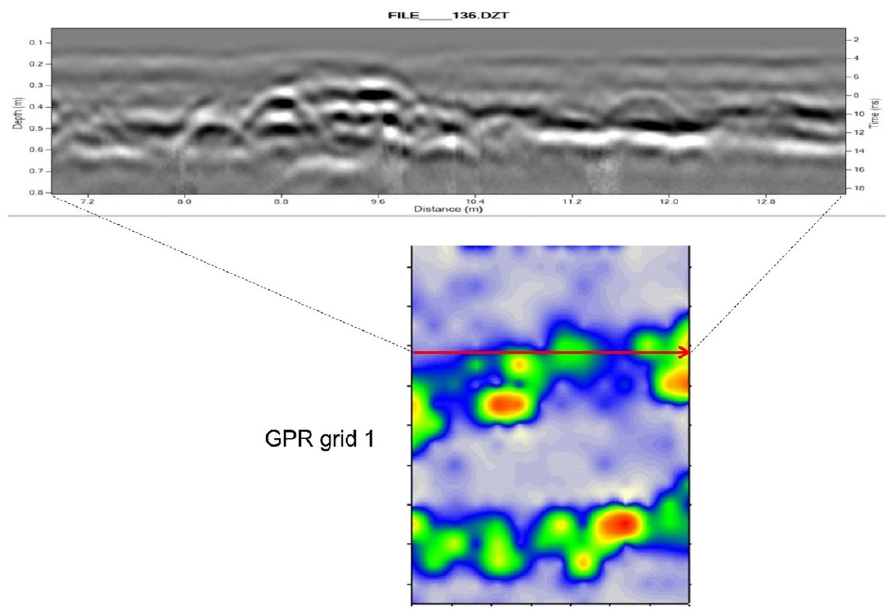
Figure 11. A transect profile paralleling the exterior wall of the southern room block at Sanchez Adobe plaza.